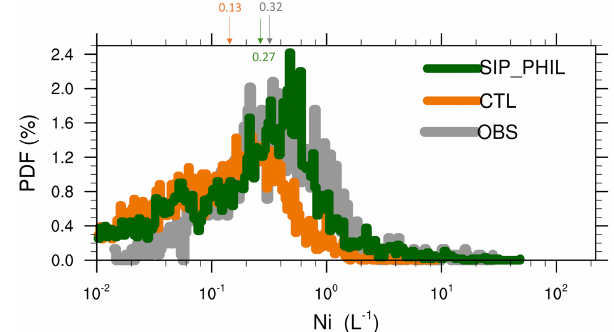
Figure 11. The probability density function (PDF) of ice crystal number concentrations from observations (gray line) and CTL (or- ange line) and SIP_PHIL simulations (green line). The arrow indi- cates the median of each distribution, which means that the set of values less (or greater) than the median has a probability of 50%. Only ice particles with diameters larger than 100µm from obser- vations and model simulations are included in the comparison. A correction factor of 1 / 4 is applied to the observed ice number con- centrations based on Jackson and McFarquhar (2014) and Jackson et al.